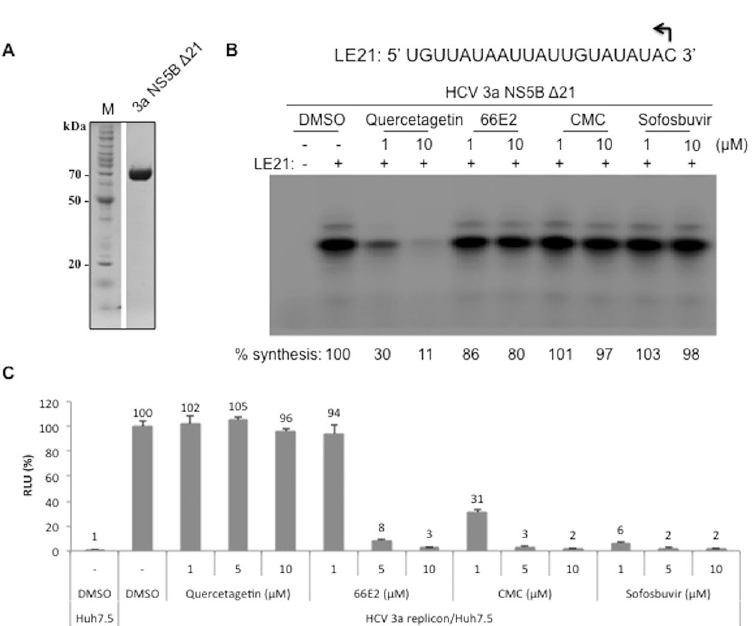
Figure 5. 66E2 does not inhibit HCV RdRp in vitro . ( A ) Coomassie stained SDS-PAGE depicting HCV RdRp lacking C-terminal 21 amino acids (3a NS5B Δ 21) that was expressed in E . coli and purified to near homogeneity (lane 2). Lane 1, Molecular weight marker. ( B ) RNA synthesis in vitro by the 3a NS5B Δ 21 in the presence of 66E2 and other known HCV inhibitors. The sequence of the template (LE21) used is given on the top. The amount of the 21-nt de novo initiated product synthesized was quantified and given as percent synthesis relative to the sample treated with only DMSO. The results presented are representative of three independent assays. ( C ) G418 resistant HCV-3a replicon expressing Huh7.5 cells were treated with varying concentrations of inhibitors. RNA replication is presented as % RLU. Reaction treated with DMSO was considered as 100%. The assays were performed in triplicates and results presented are representative of three independent assays. The % mean is shown above the bars and the error bars are standard